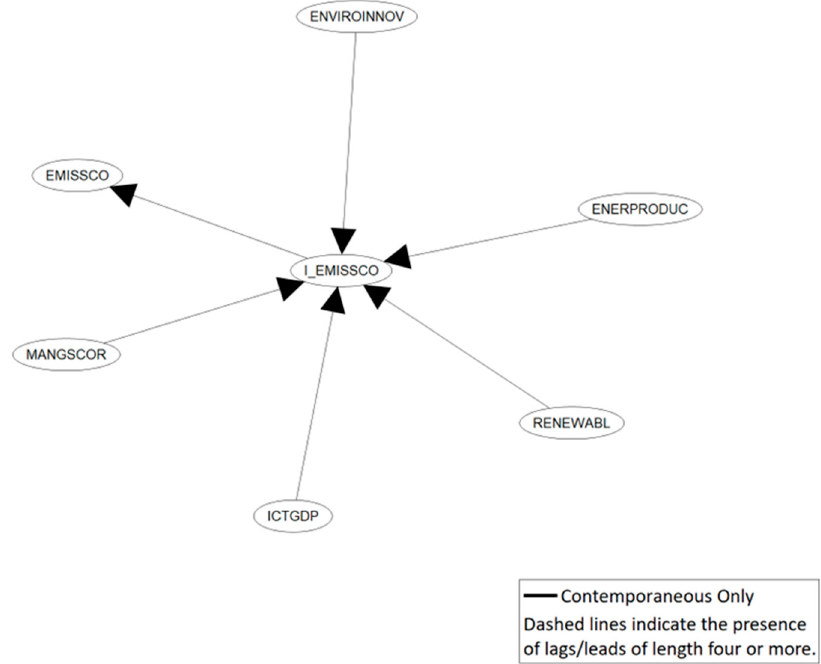
Figure 4. The interlinkages of the model variables. Source: Eviews 12.